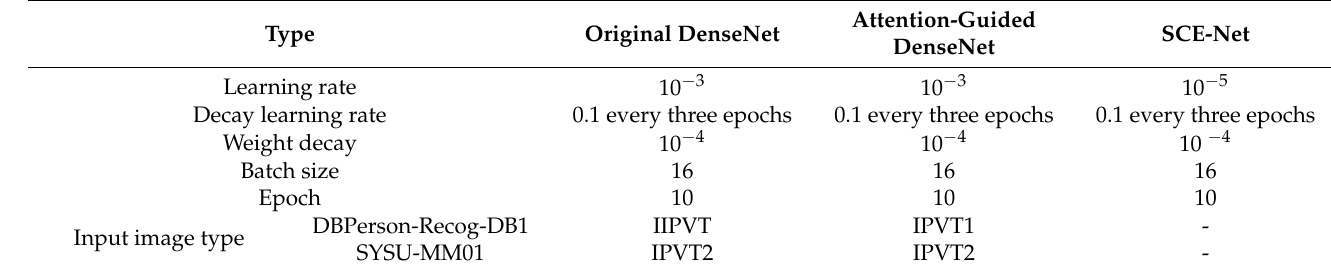
Table 2. Training parameters and input image types for each